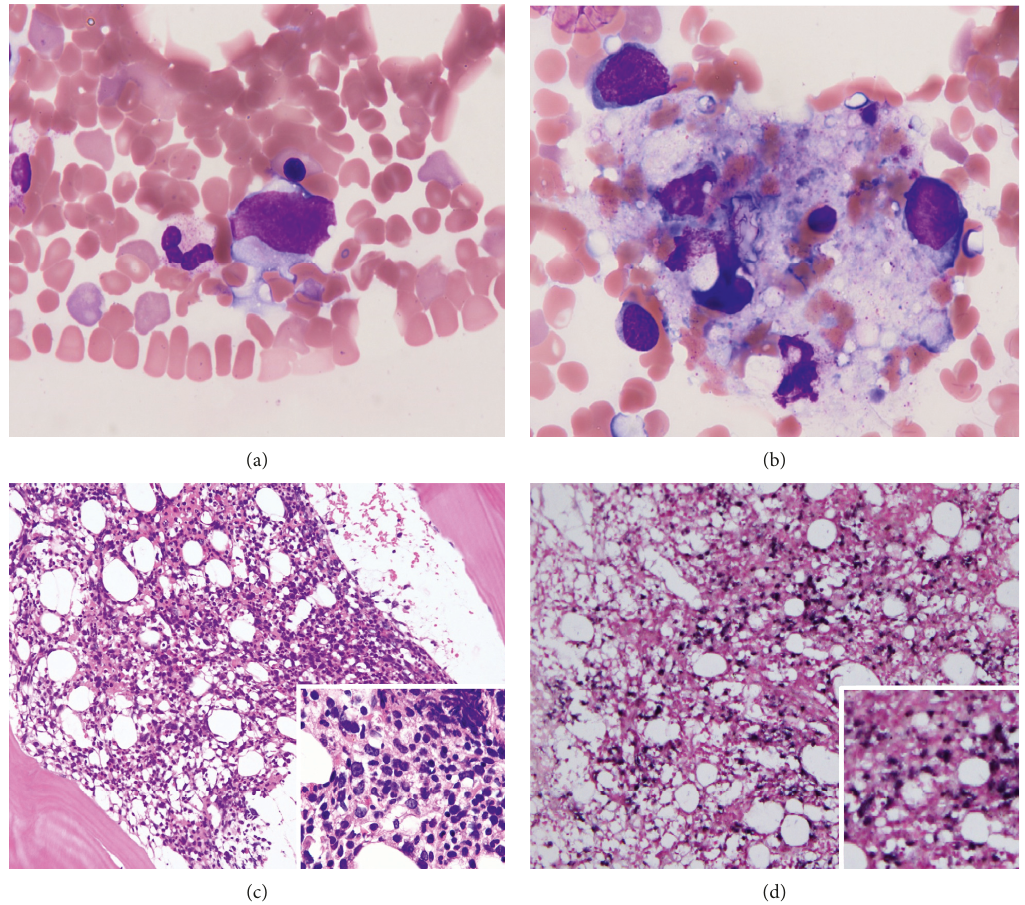
Figure 1: Bone marrow aspiration/biopsy findings. (a, b) Bone marrow aspirate. Wright-Giemsa staining. (a) A large, atypical lymphocyte ( × 1,000). (b) Hemophagocytosis ( × 1,000). (c, d) Bone marrow biopsy showing hypercellular marrow. (c) Hematoxylin and eosin staining. Low-magnification image ( × 40). Inset: high-magnification image ( × 200). (d) Epstein–Barr virus-encoded RNA (EBER) in situ hybrid- ization. Large atypical lymphocytes are positive. Low-magnification image ( × 40). Inset: high-magnification image ( × 200).